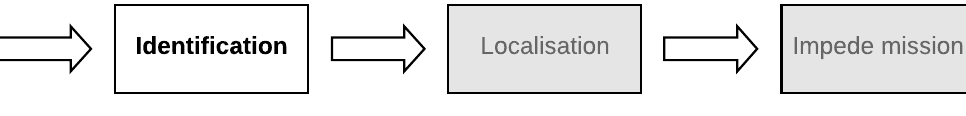
Figure 1. Proposed Anti-drone